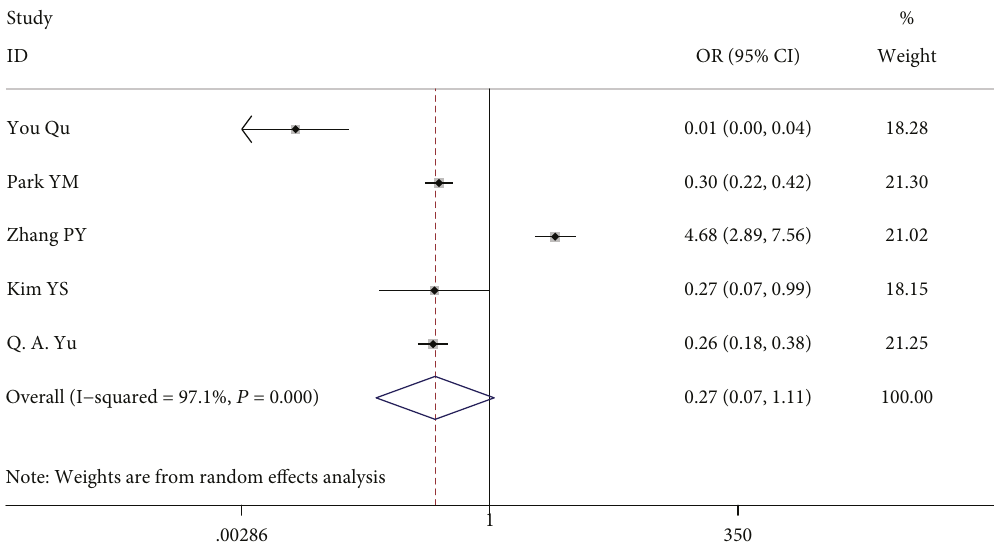
Figure 4: Forest plot for metastasis according to tumour size < 1 cm vs. tumour size ≥ 1cm .